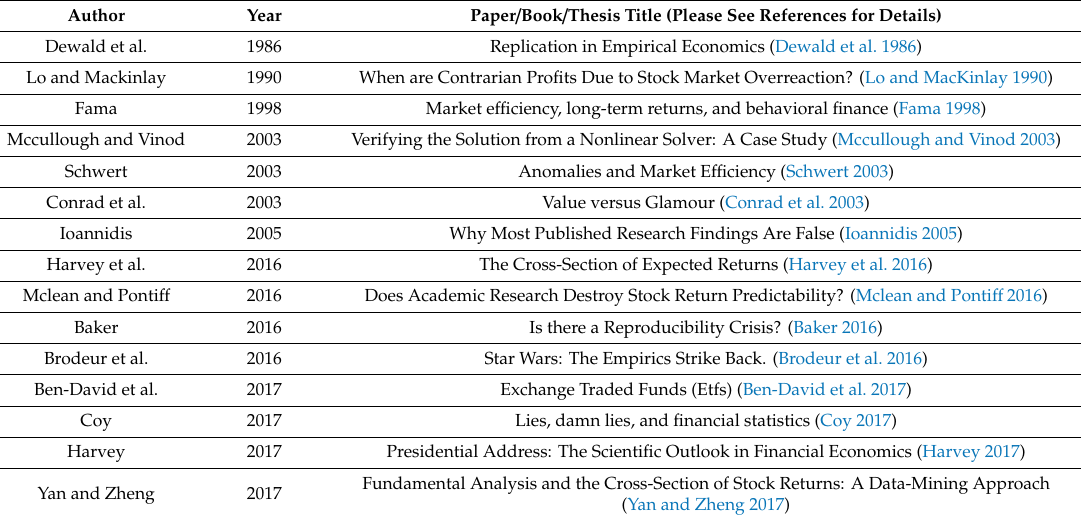
Table 6. Selected work on Replication: A Futuristic